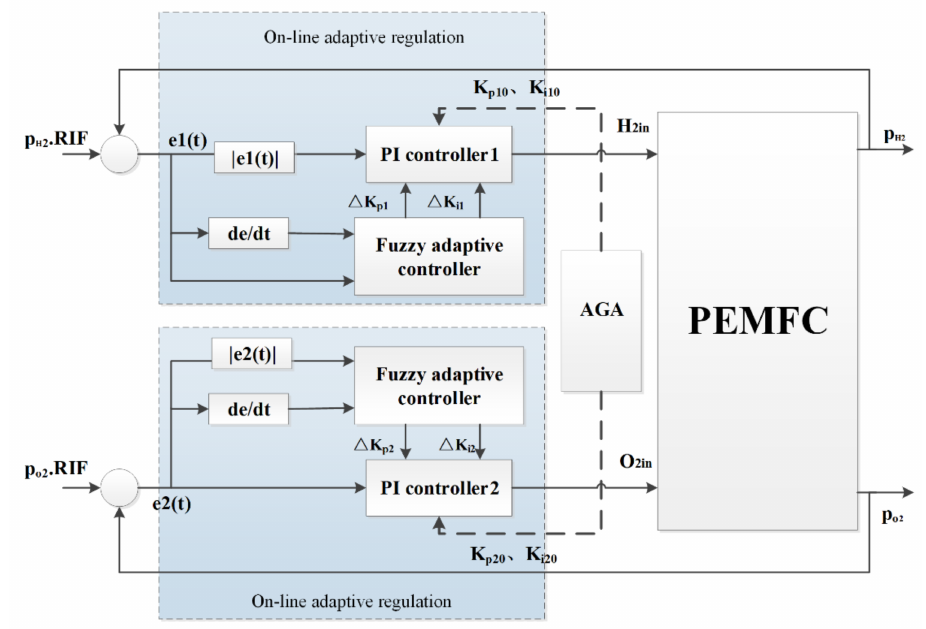
Figure 2. Hybrid adaptive fuzzy–AGA–PI decoupling control